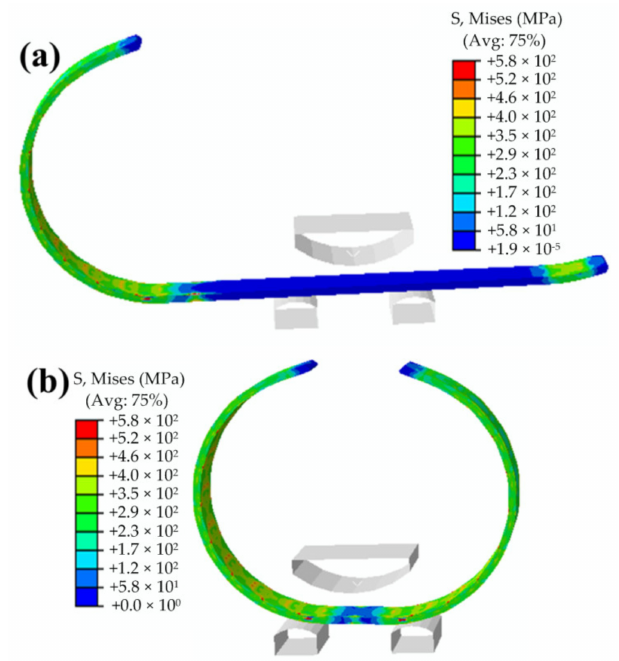
Figure 8. Mises stress contours: ( a ) “J” forming and ( b ) “C” forming.